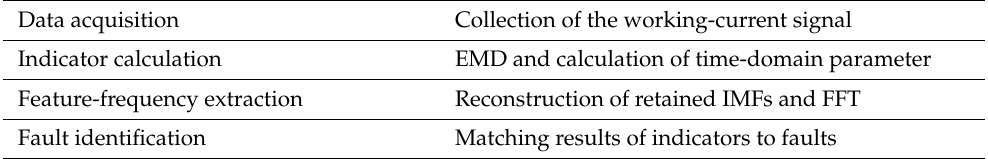
Table 4. The fault-detection framework.